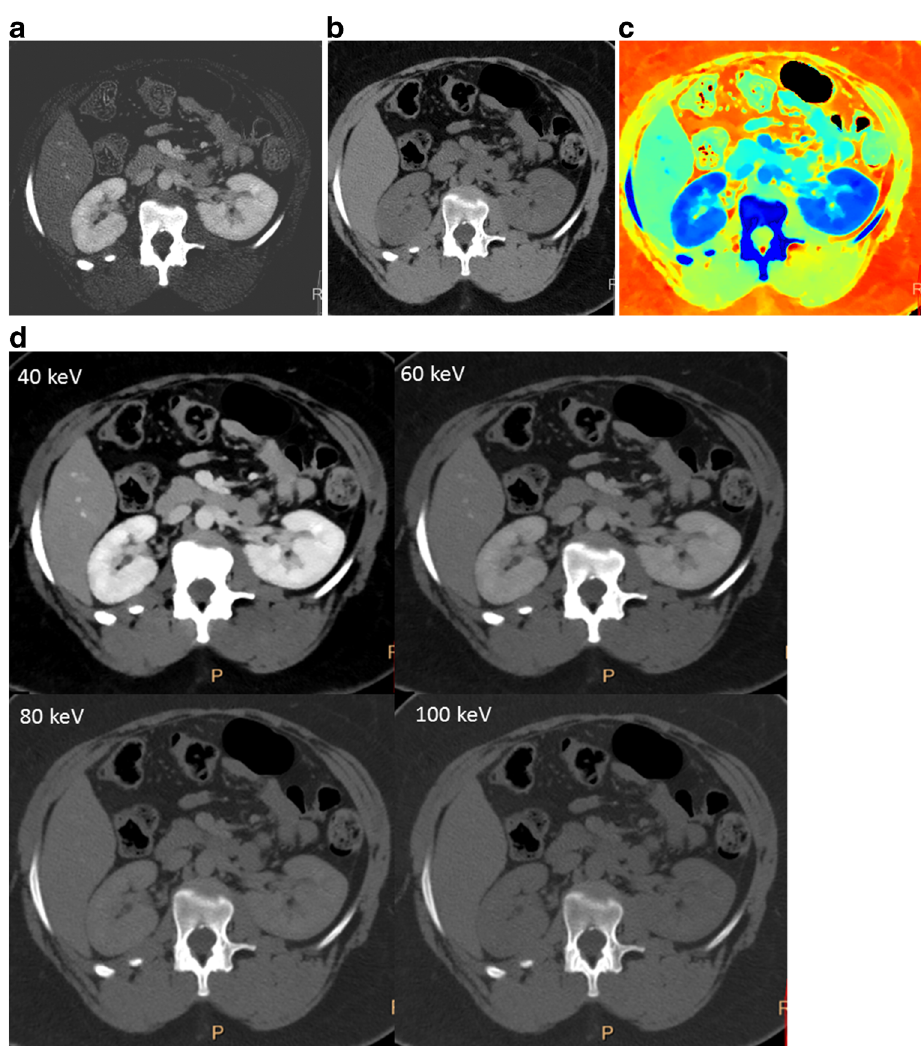
Fig. 2 SDCT images. ( a ) Iodine- only image, highlighting tissues containing iodine. ( b ) Virtual non-contrast image, obtained after removal of pixels containing iodine. ( c ) Effective atomic number-based image, where the colour depends on the effective atomic number. ( d ) Virtual monoenergetic images at 40 keV, 60 keV, 80 keVand 100 keV. The contrast signal is highest in the 40-keV image, with the signal progressively decreasing at higher